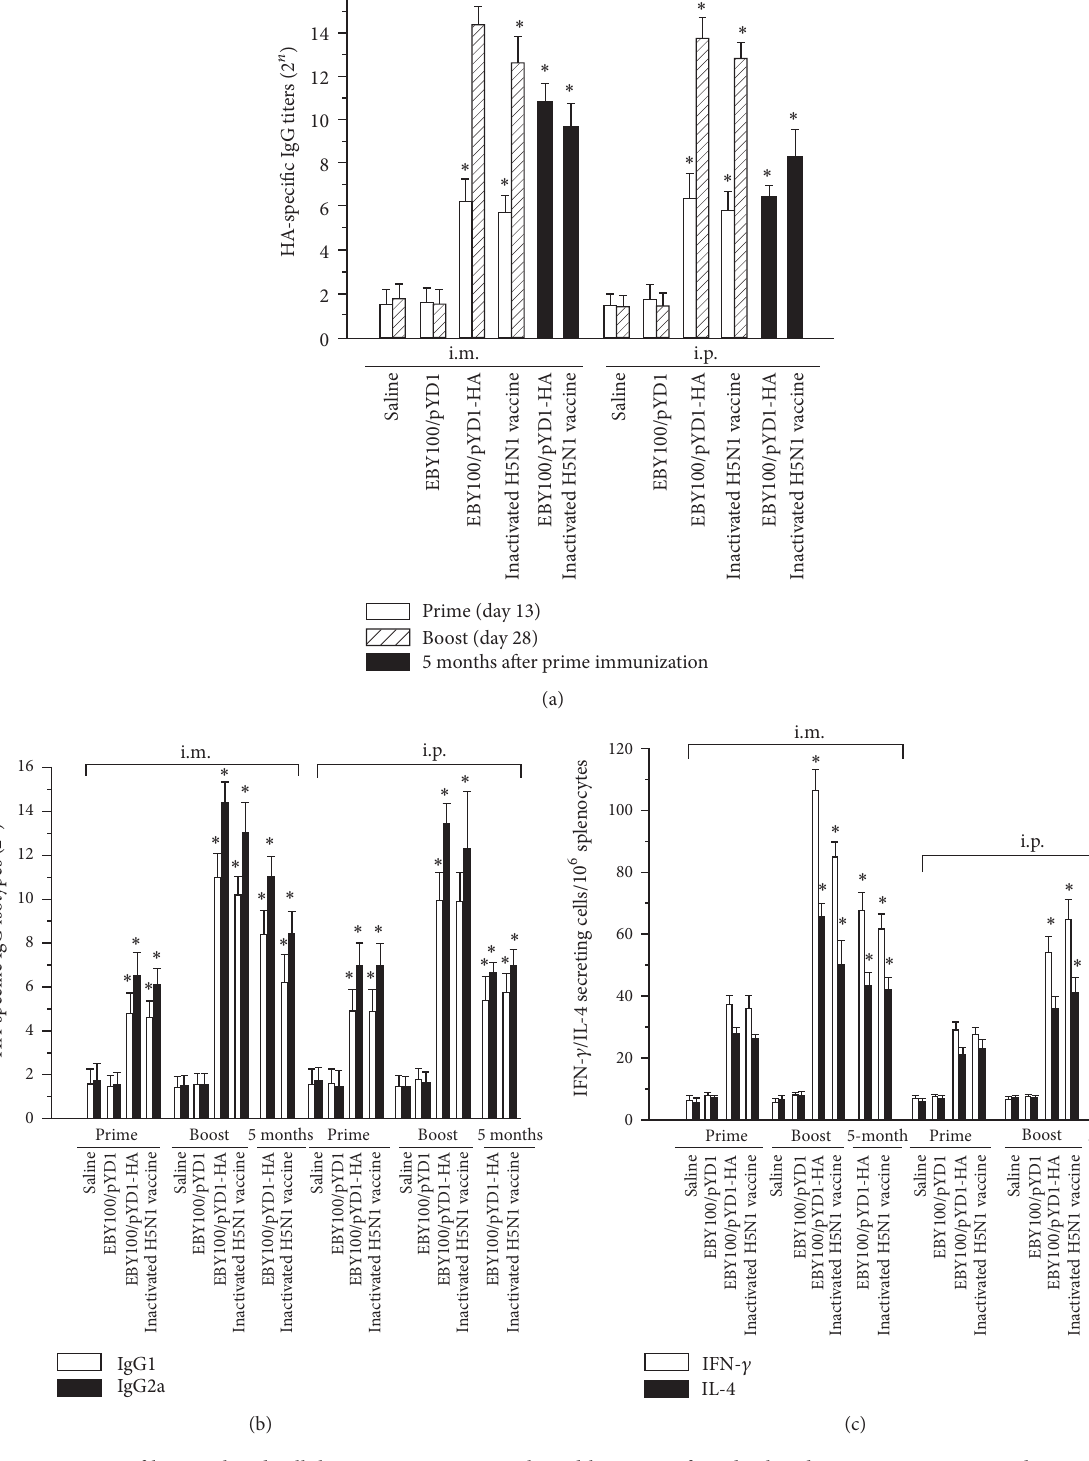
Figure 4: Detection of humoral and cellular immune response elicited by HA surface-displayed vaccines in immunized mice. Sera were collected from vaccinated mice and tested for production of (a) HA-specific IgG antibodies at day 13 ( 𝑛 = 21 mice/group), day 28 ( 𝑛 = 21 mice/group), and 5 months ( 𝑛 = 5 mice/group) after prime immunization and (b) IgG isotypes. (c) The numbers of IFN- 𝛾 /IL-4 secreting T cells in vaccinated mice. Splenocytes were isolated from vaccinated mice at day 10 ( 𝑛 = 3 mice/group) and day 24 ( 𝑛 = 3 mice/group) after the prime immunization and evaluated by ELISpot. Data are represented as mean ± SD. Asterisk indicates significant difference, as compared to the controls (PBS and EBY100/pYD1 injected mice) ( ∗ 𝑝 < 0.05